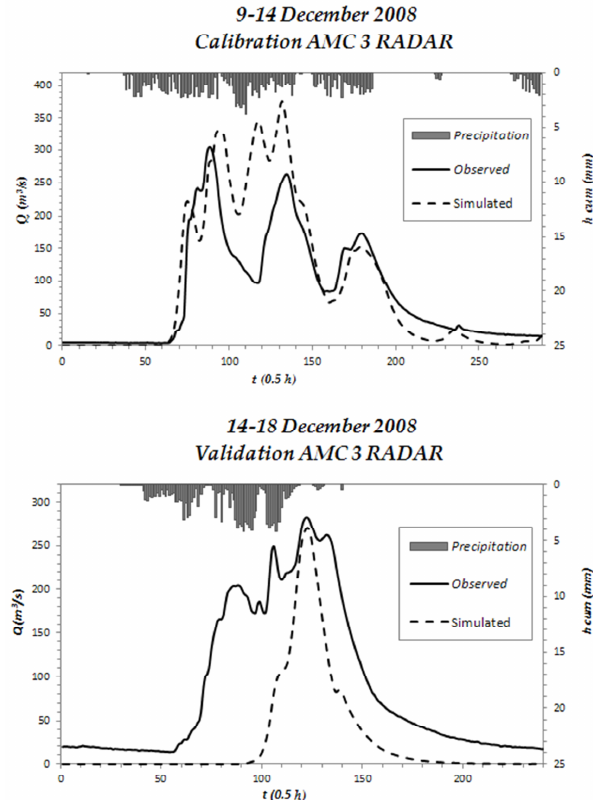
Fig. 4. Calibration and validation of the AMCIII class hydrologic model for the Mignone River basin on the basis of the observed hydrographs at the “Aurelia” gauge station in December 2008 with radar